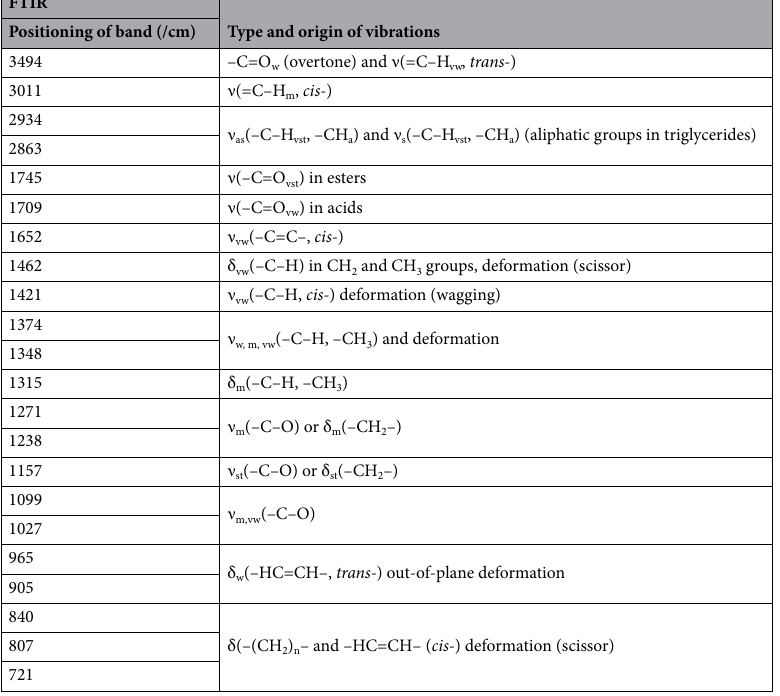
Table 4). The vibrations with the maximum at approx. 2934, 2863/cm originate from the stretching –C–H vibra- tions in the –CH3, CH2 groups belonging to triglyceride aliphatic groups 21–29 .